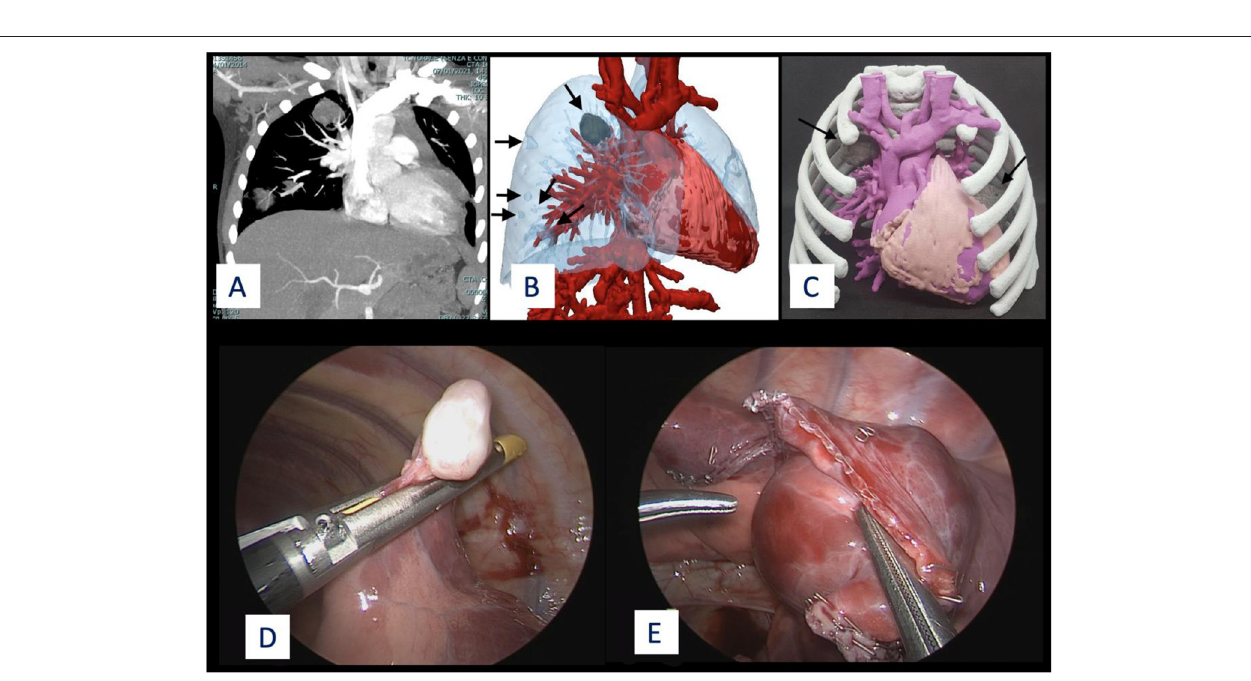
FIGURE 2 | Cystic lesions after surgery and chemotherapy for a pleuropulmonary blastoma in a 7-year-old boy, who then underwent MIS excision of multiple masses. (A,B) Reconstruction and 3D model of the lesions. (C,D) Intraoperative thoracoscopic view. (E) Post-operative X-ray.